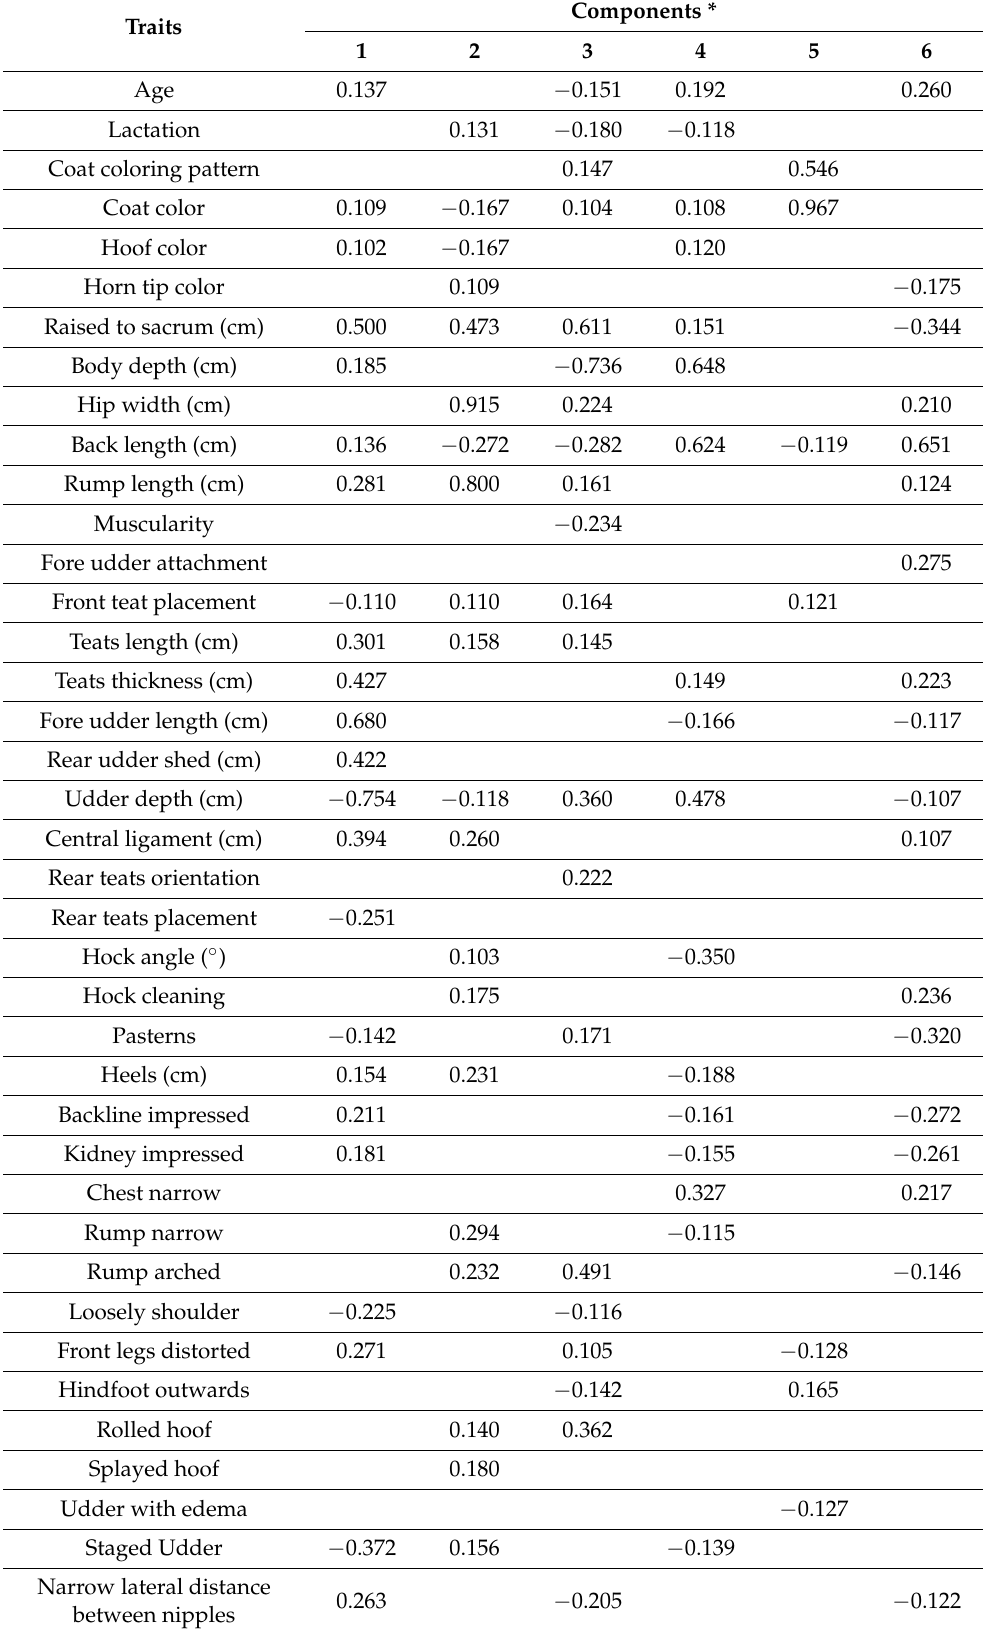
Table 5. Correlation matrix of initial traits according to selected